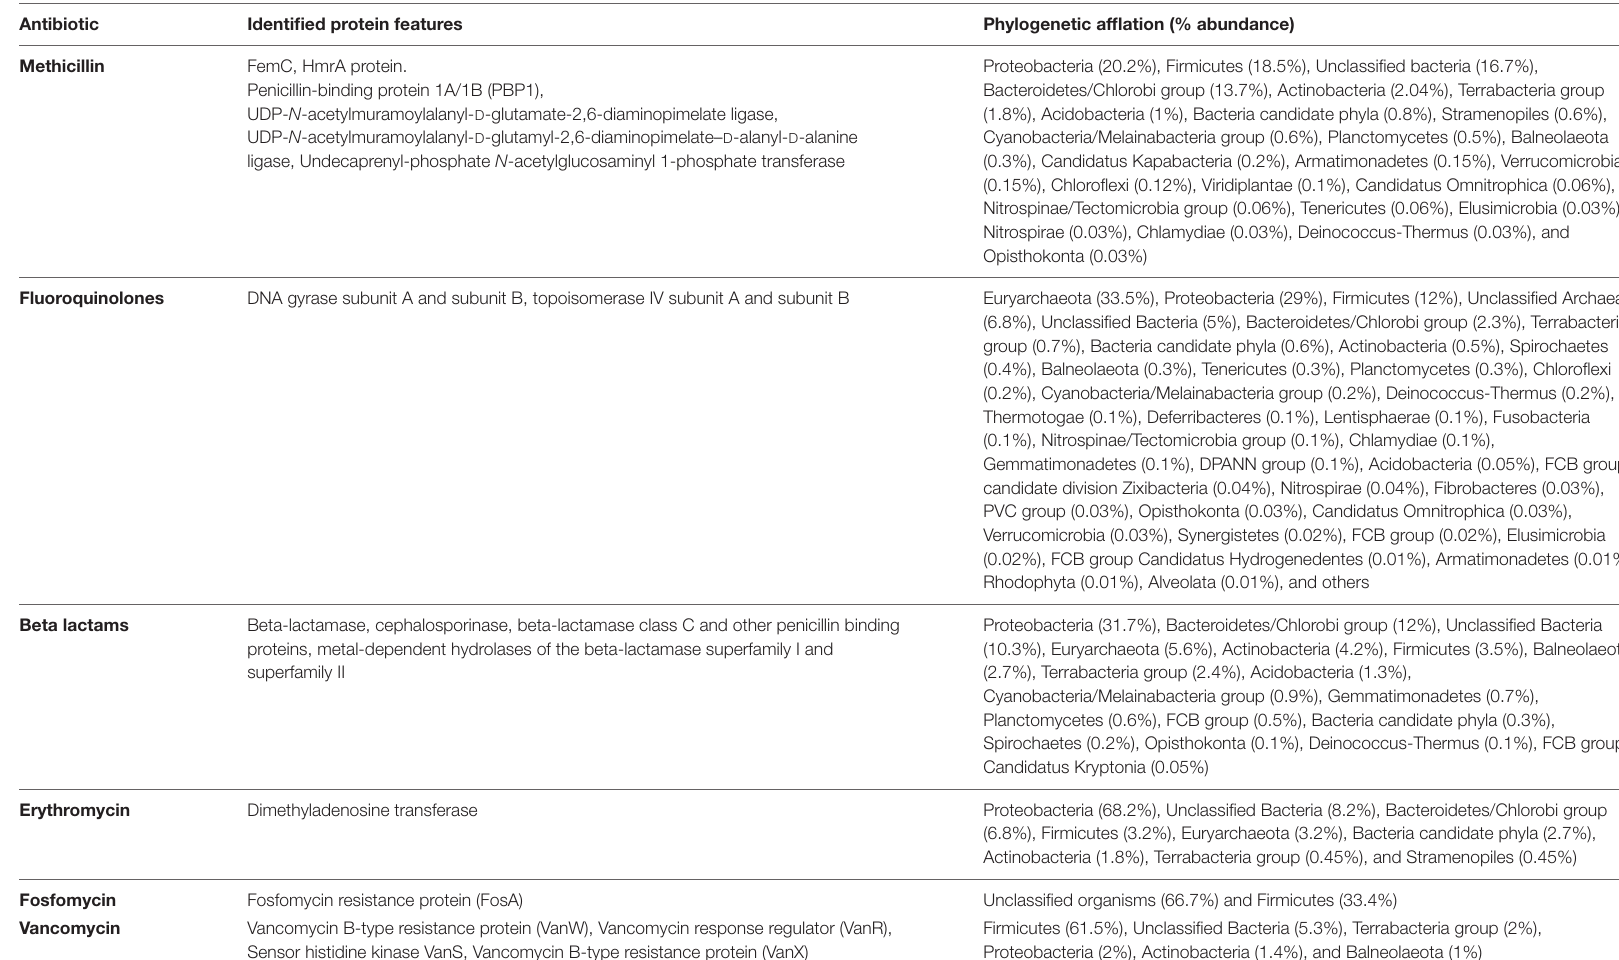
TABLE 3 | Metagenomic features associated with antibiotic stress response physiology in Sambhar Salt Lake microbiome. Antibiotic Identified protein features Phylogenetic afflation (%